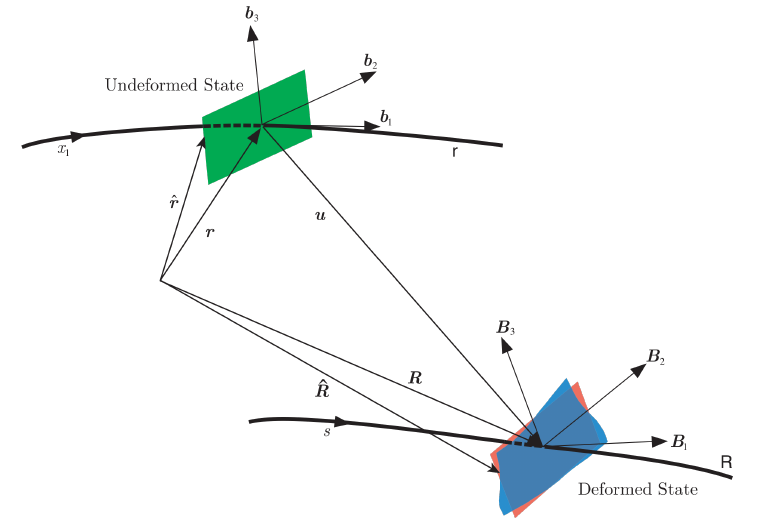
Figure 5. Beam kinematics in deformed and undeformed states. The green color shows the undeformed section, red represents the deformed section without considering the warping effect, and the blue color shows the warping effect on the deformed